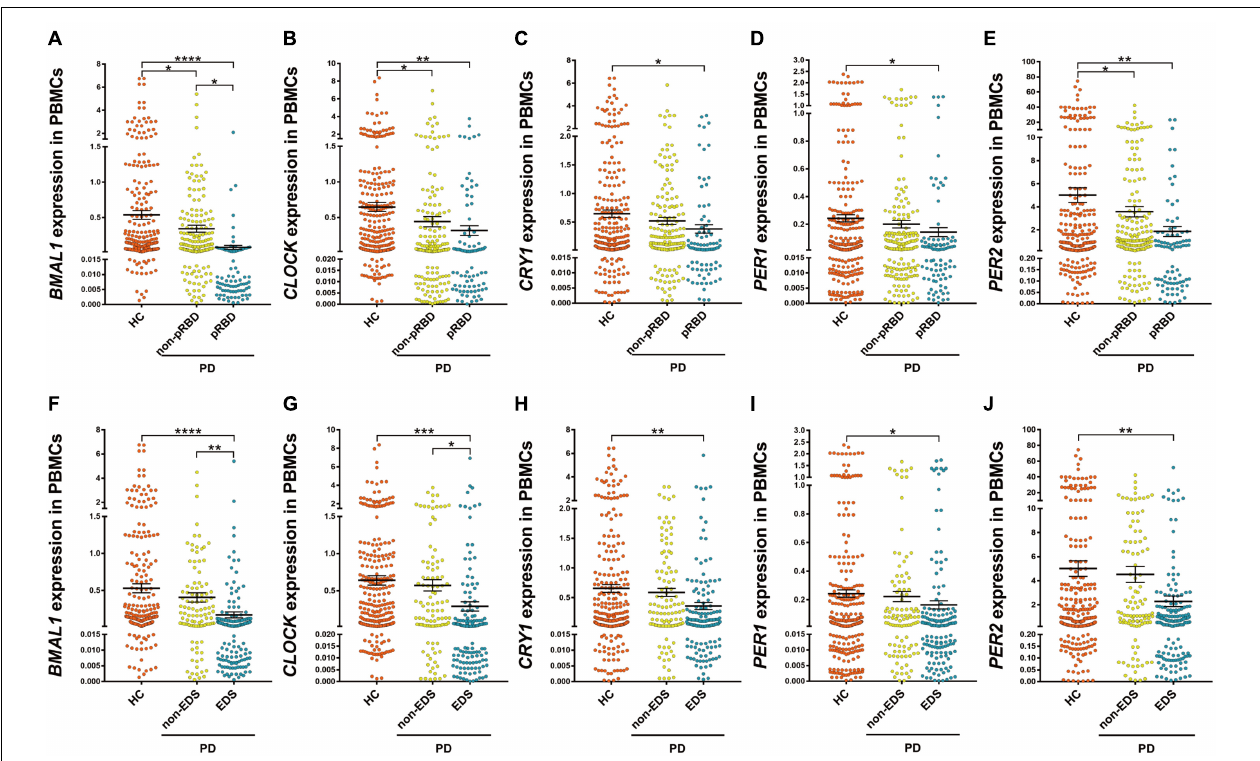
FIGURE 2 | Scatter plots of BMAL1 , CLOCK , CRY1 , PER1, and PER2 relative mRNA expression levels in the PBMCs of HC and different subgroups of PD. (A–E) PD patients with pRBD ( n = 88) had significantly lower expression levels of five clock genes compared with those in HC ( n = 314, BMAL1 , P < 0.0001; CLOCK , P < 0.01; CRY1 , P < 0.05; PER1 , P < 0.05; PER2 , P < 0.01, respectively), and had decreased level of BMAL1 compared with that of PD patients without pRBD ( n = 176, P < 0.05). (F–J) Expression levels of all five clock genes in PD patients with EDS ( n = 160) were significantly lower than that of HC ( n = 314, BMAL1 , P < 0.0001; CLOCK , P < 0.001; CRY1 , P < 0.01; PER1 , P < 0.05; PER2 , P < 0.01, respectively). Significantly differences of BMAL1 ( P < 0.01) and CLOCK ( P < 0.05) expression levels were seen between the subgroups of PD patients with EDS and without EDS. Horizontal bars represent mean and SE values.